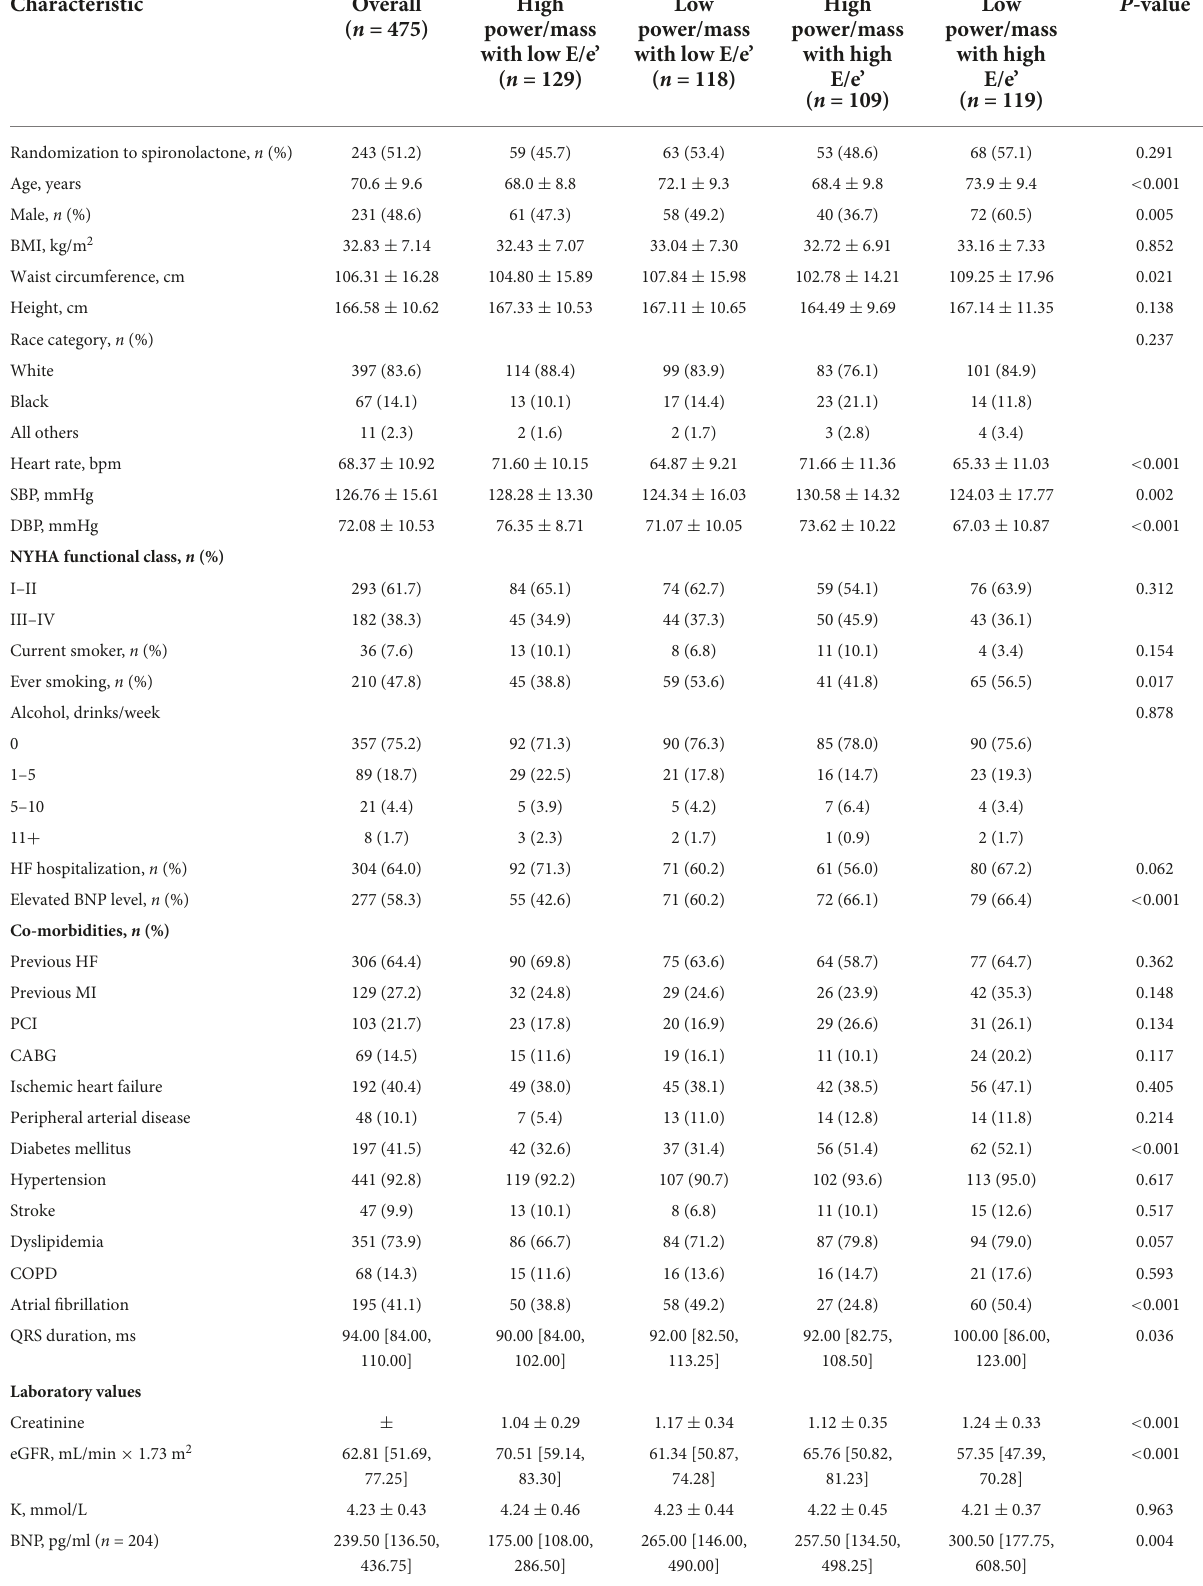
TABLE 1 Baseline characteristics of HFpEF patients by power/mass and E/e’ ratio categories.